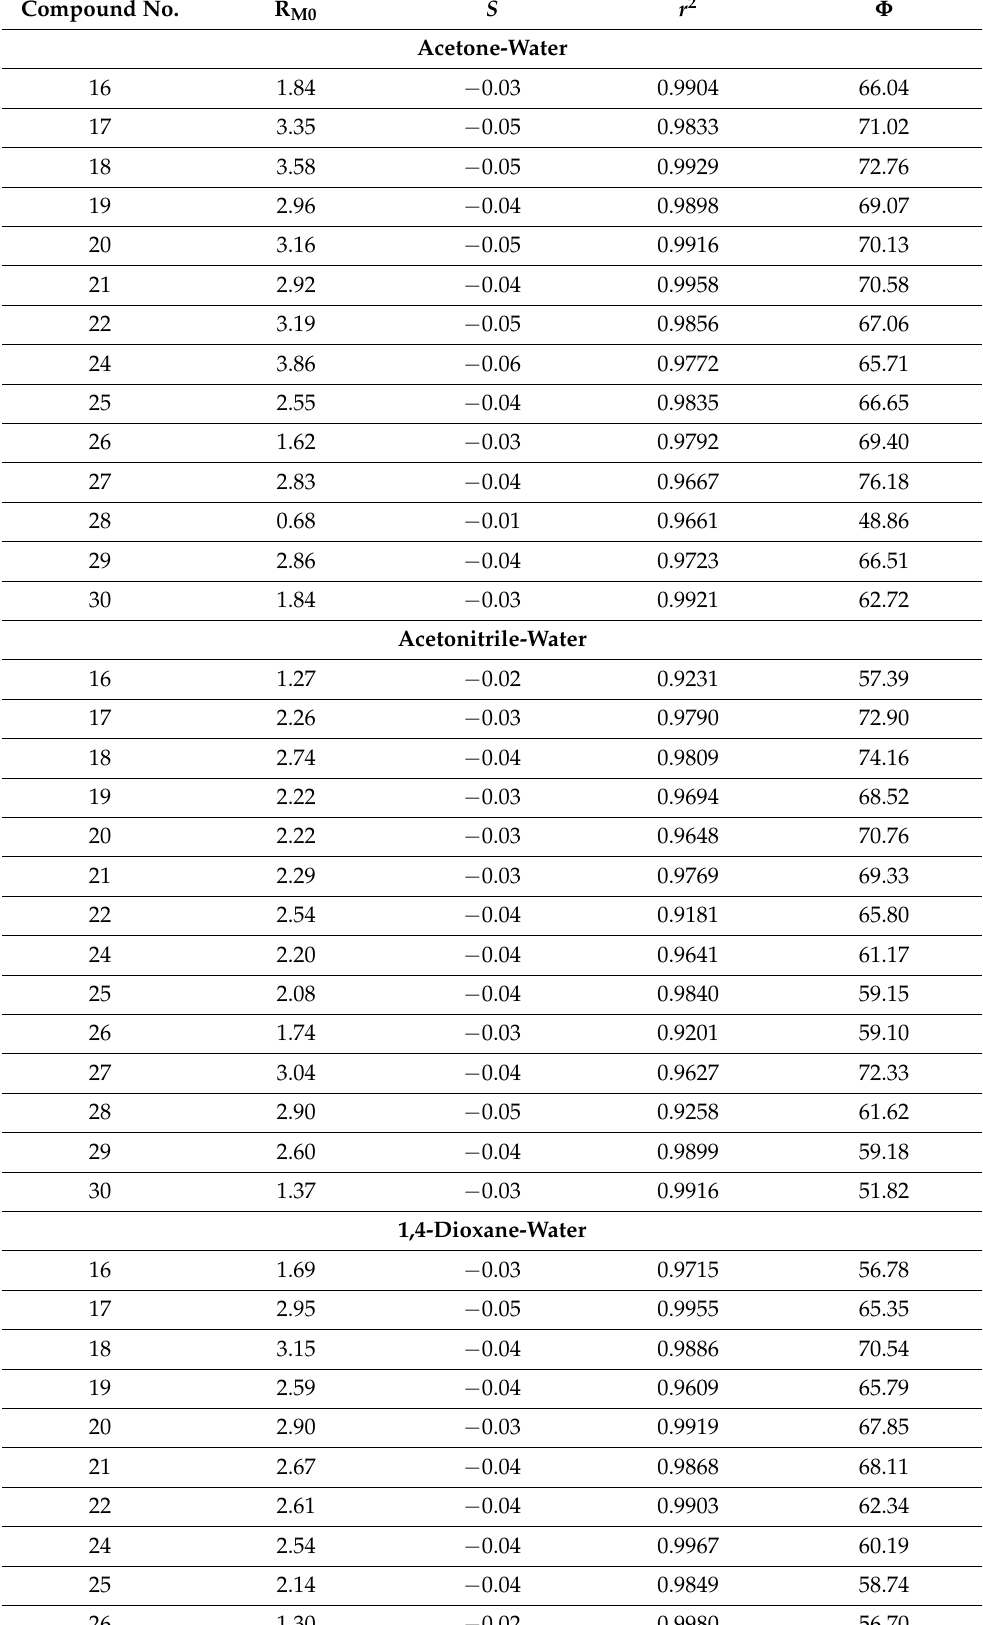
Table 6. The R M0 values of the synthesized 1,3,4-oxadiazoline derivatives. Compound